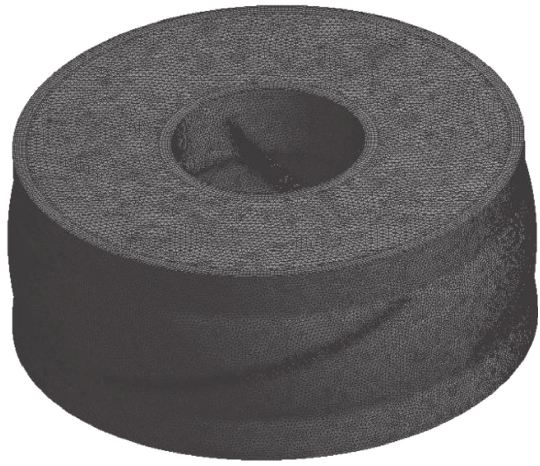
Figure 3: The grid of the impeller.